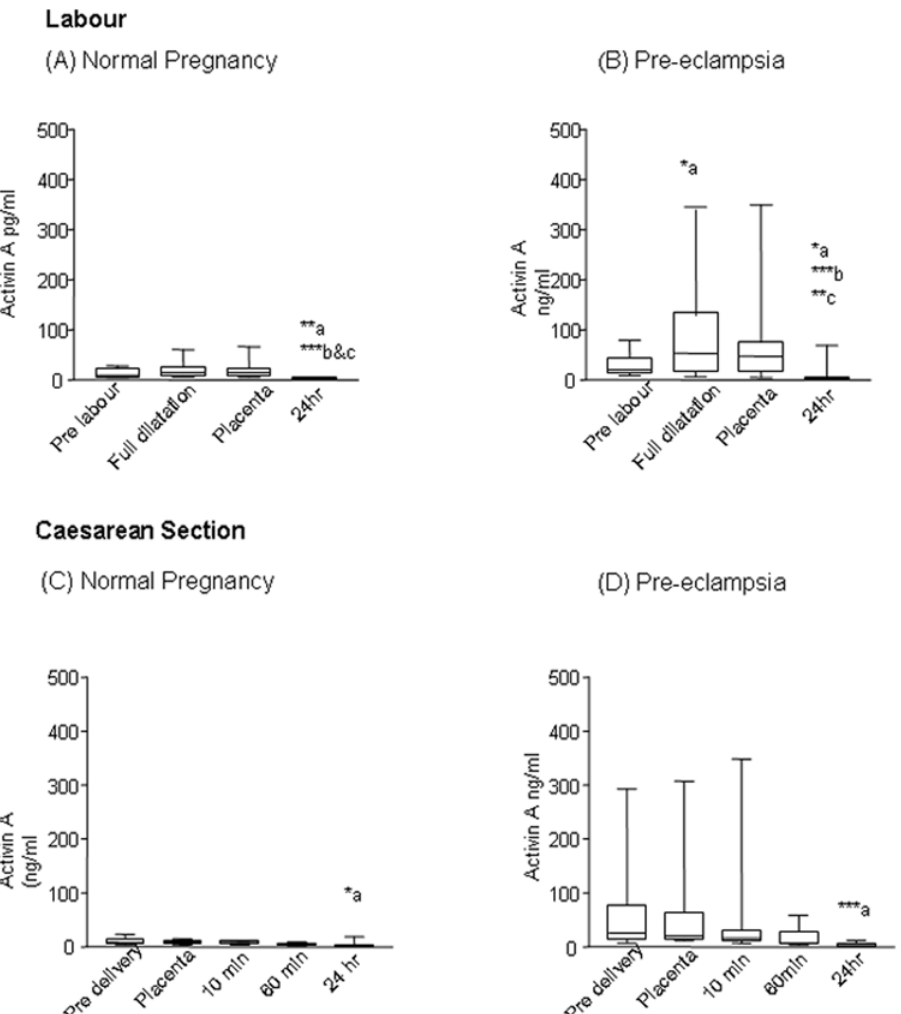
Figure 1. Activin A levels (median (ranges) ng/ml) in maternal plasma during labour (A,B) and Caesarean section (C,D) in normal pregnancy (n=10) and women with pre-eclampsia (n=10). In normal pregnancy labour (A) there was a significant decline in activin A levels by 24 hr (a**p , 0.01, pre-labour vs 24 hr, b ***p , 0.001-full dilatation vs 24 hr, and c***p , 0.001-placental delivery vs 24 hr. In pre-eclampsia labour (B) there was a significant increase in levels of activin A, (a*p , 0.05 pre-labour vs full dilatation) and a significant decline postpartum (a*p , 0.05 pre- labour vs 24 hr, b***p , 0.001-full dilatation vs 24 hr, and c**p , 0.01-placental delivery vs 24 hr). At Caesarean section a significant decline in levels of activin A by 24 hr was noted with placental delivery in normal pregnancy and pre-eclampsia (C,D). (NP a*p , 0.05 and PE, a ***p , 0.001 placental delivery vs 24 hr).